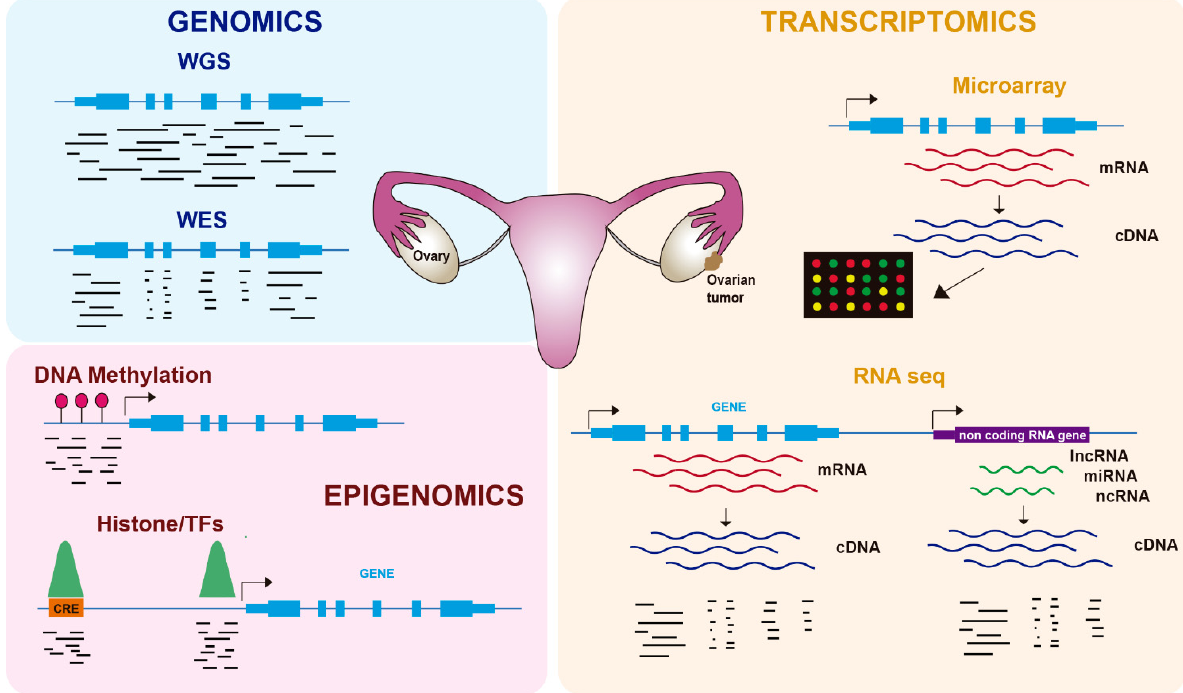
Figure 1. Genomic, transcriptomic, and epigenomic techniques have revolutionized our understanding of OC. The main approaches to inspect the genomic landscape of OC are whole-genome sequencing (WGS), which consists of sequencing of both coding and noncoding DNA, and whole-exome sequencing (WES), in which exons are captured and sequenced at high coverage. Transcriptomic approaches include microarray platforms, which quantify mRNA expression levels using fluorescent probes, and RNA-seq, which sequences total cDNA from both mRNAs and ncRNAs. Epigenomic approaches comprise the study of global DNA methylation, using techniques such as bisulfite sequencing, and the genome-wide en- richment of histone modifications or TF binding by ChIP-seq. Table 1. Histological, clinical, and molecular features of ovarian cancer subtypes. OS, overall survival; GIN, genetic insta- bility; HR, homologous recombination. Histology